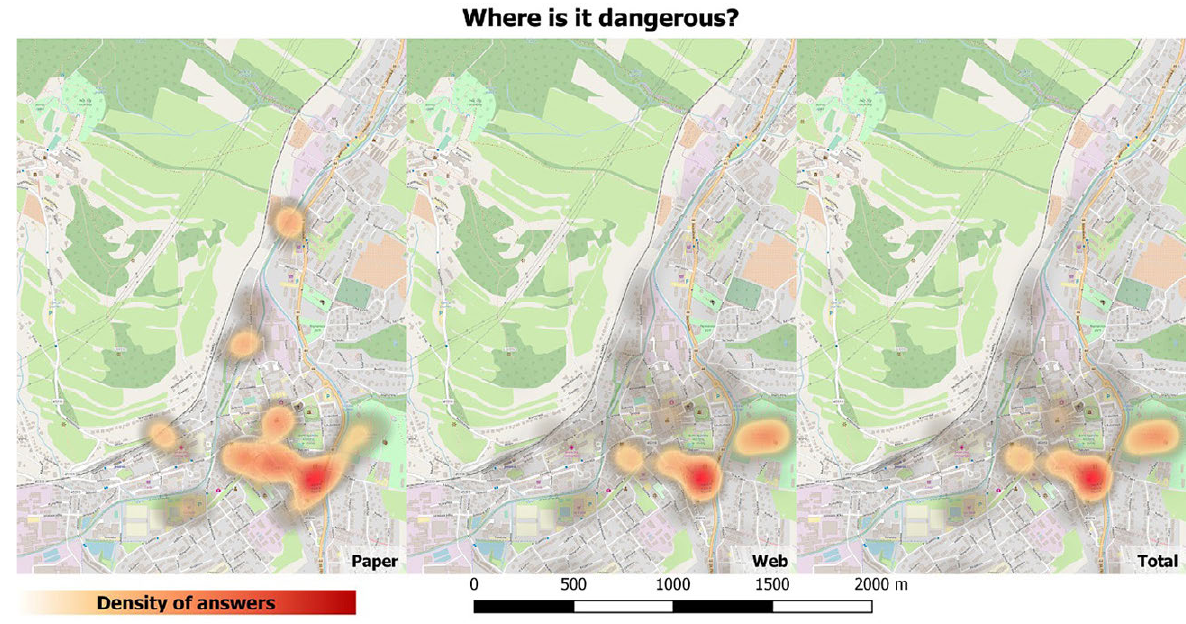
Fig. 5. Where do respondents think it is dangerous in